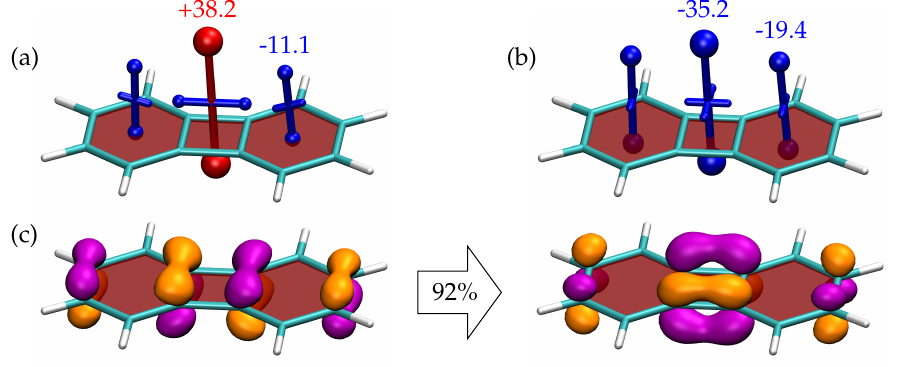
Figure 5. Visualisation of chemical shielding tensors (VIST) for ( a ) the S 0 and ( b ) the T 1 states of 2 computed 1 Å above the molecular plane. The dominant pair of natural transition orbitals (isovalue 0.07 a.u., weight 92 %) for the S 0 → T 1 transition is shown in ( c